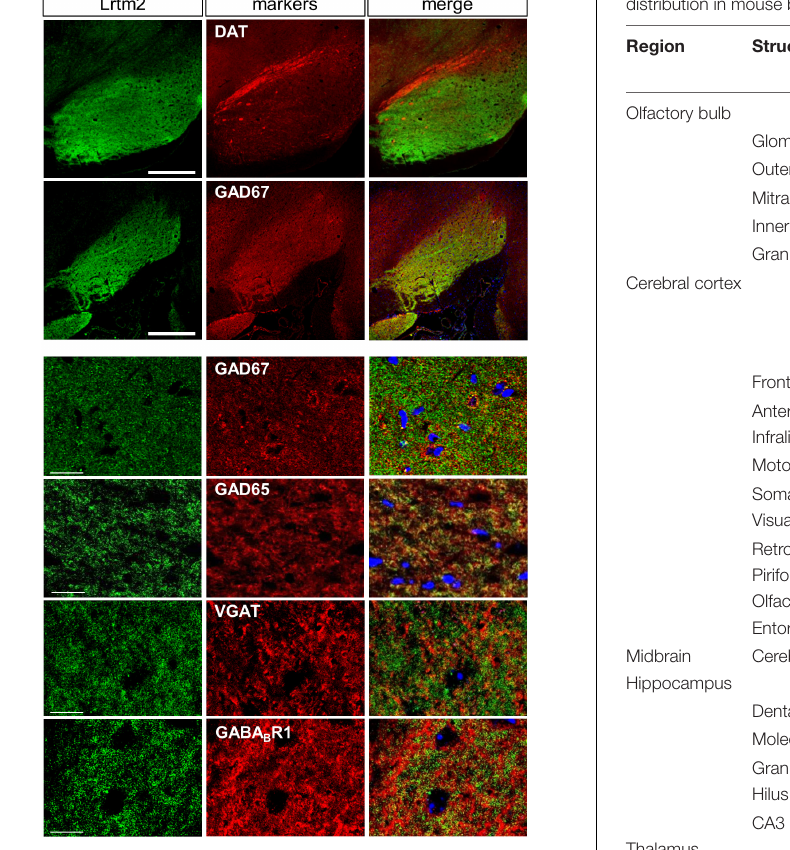
TABLE 1 | Comparison of Lrtm2 mRNA and Lrtm2 protein distribution in mouse